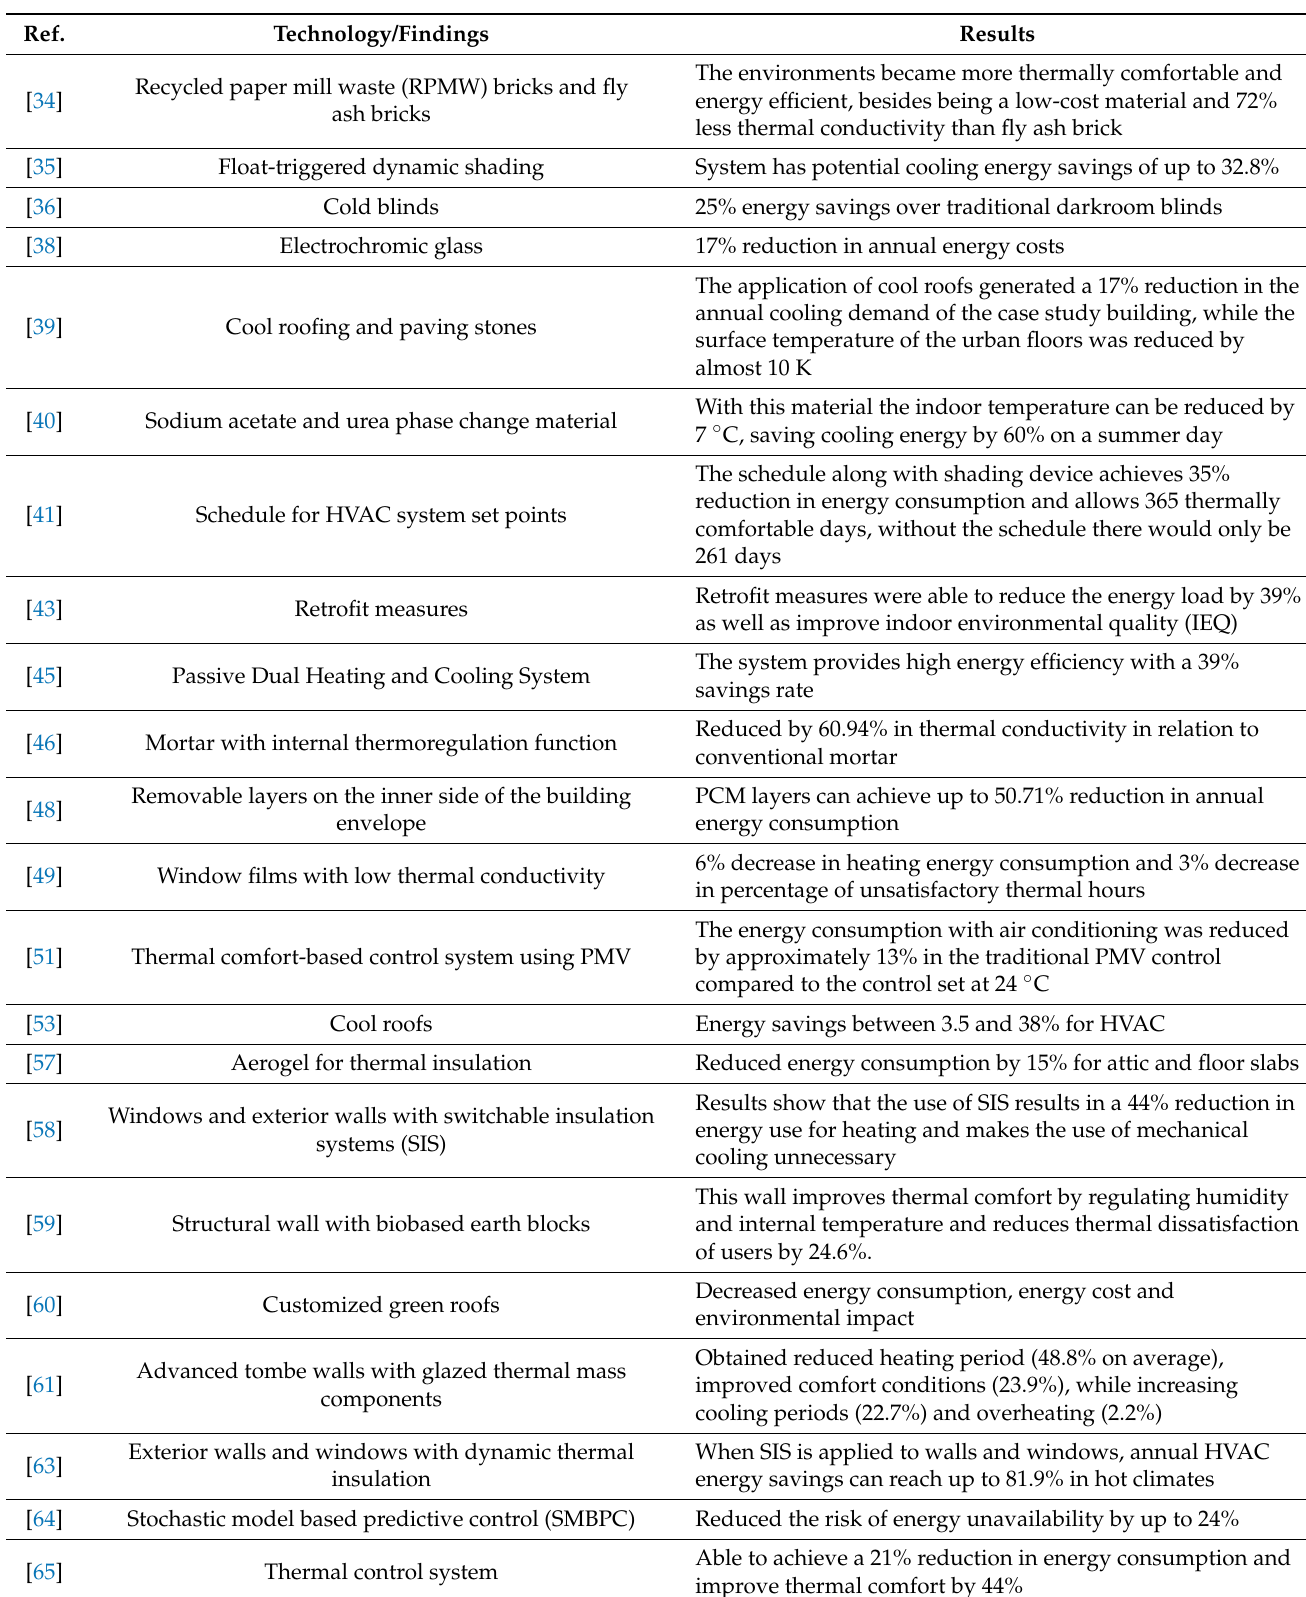
Table 3. New technologies and findings to improve thermal comfort and reduce energy consumption.